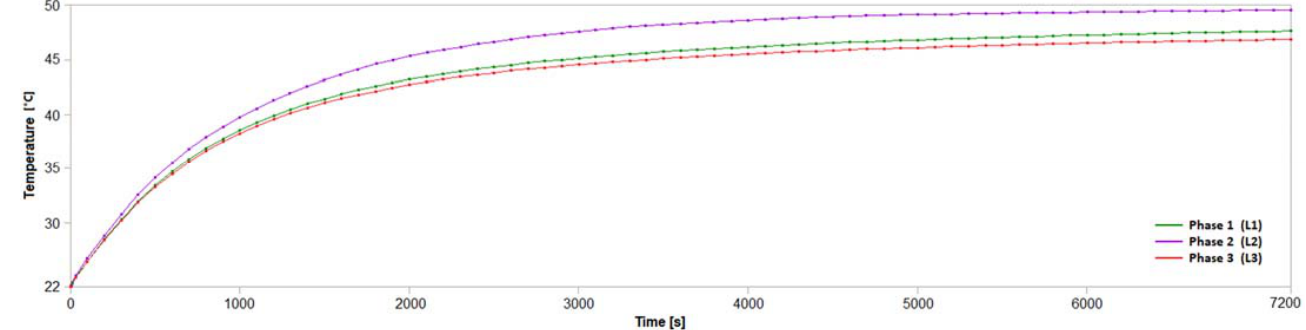
Figure 8. The characteristics of the theoretical establishment of the temperature value in the current busbars.